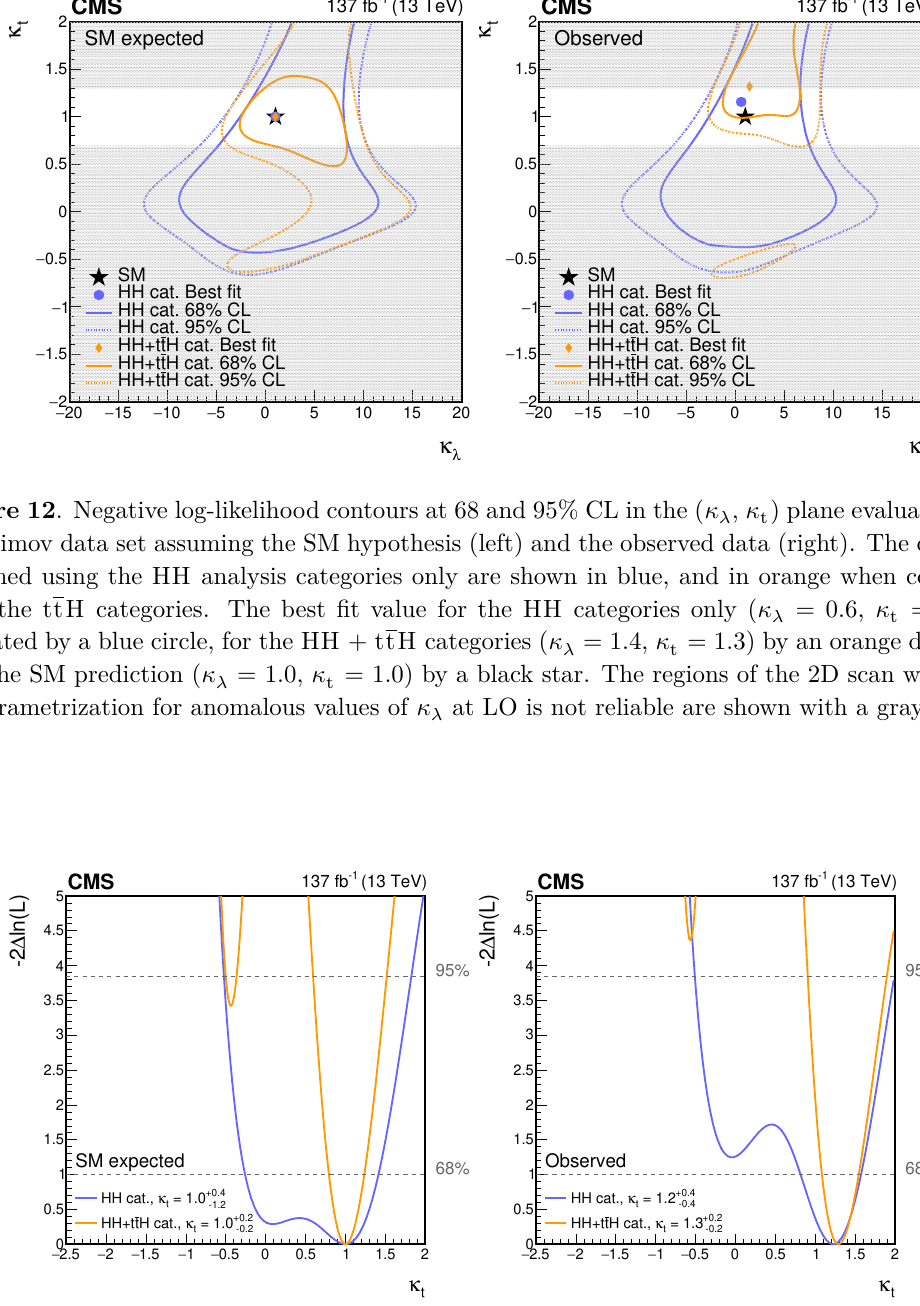
, evaluated with an Asimov data set Figure 13 . Negative log-likelihood scan, as a function of κ t assuming the SM hypothesis (left) and the observed data (right). The 68 and 95% CL intervals are shown with the dashed gray lines. The two curves are shown for the HH (blue) and the HH + ttH (orange) analysis categories. All other couplings are fixed to their SM